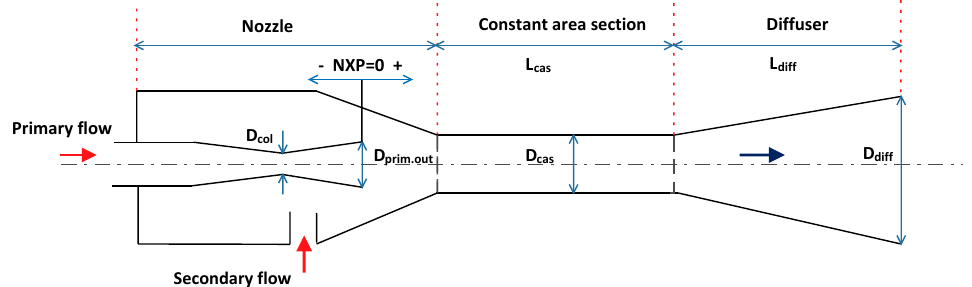
Figure 3. Schematic view of the ejector